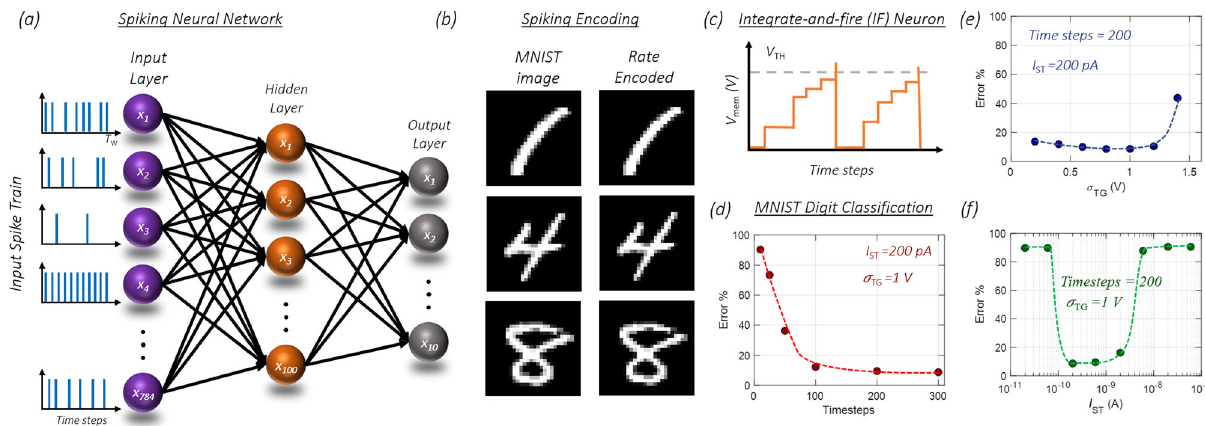
Fig. 5 Encoding of MNIST data for digit classi fi cation using SNN. a A fully connected two-layered trained ANN with 100 neurons in the hidden layer and 10 neurons in the output layer for MNIST digit-classi fi cation is transformed into SNN. b Examples of spike encoded digits. First, the pixel intensity values ranging from 0 to 255 are mapped on to V PSV values in the range of 0 – 5 V. Next, we recorded I PSC for each V PSV by applying stochastic V TG pulses with I ST = 200 pA to generate binary spike trains ( X ) in time. We adopt rate-based encoding by applying V TG pulses with the pulse magnitude determined using a random Gaussian distribution with μ TG = − 5.5 V, and σ TG = 1 V. c Characteristics of IF neuron which is substituted for ReLU for ANN-SNN conversion. In the IF neuron when the membrane potential crosses a certain threshold ( V TH ), the neuron spikes, propagating spike to the next layer, and it resets back to its resting potential which is set as zero. d Inference error versus the number of timesteps for classifying a set of 10,000 test images. Increasing the number of timesteps is important to allow suf fi cient fi ring, to effectively encode the pixel intensities. But even with 200 timesteps, we achieve a low error of 9.5%. Dependence of inference accuracy on e σ TG , and f I ST . The minimum error of ≈ 8.6% is achieved at σ TG = 0.8 V. For lower σ TG , the dynamic range is insuf fi cient to capture the variation in pixel intensities, whereas, for very high σ TG , there is insuf fi cient difference between the fi ring rates corresponding to different pixel intensities resulting in larger errors. Similarly, the minimum error of 8.6% is obtained for I ST = 200 pA. For higher I ST , the spiking is minimal resulting in an inadequate representation of image pixels, whereas, for lower I ST , any pixel intensity results in excessive fi